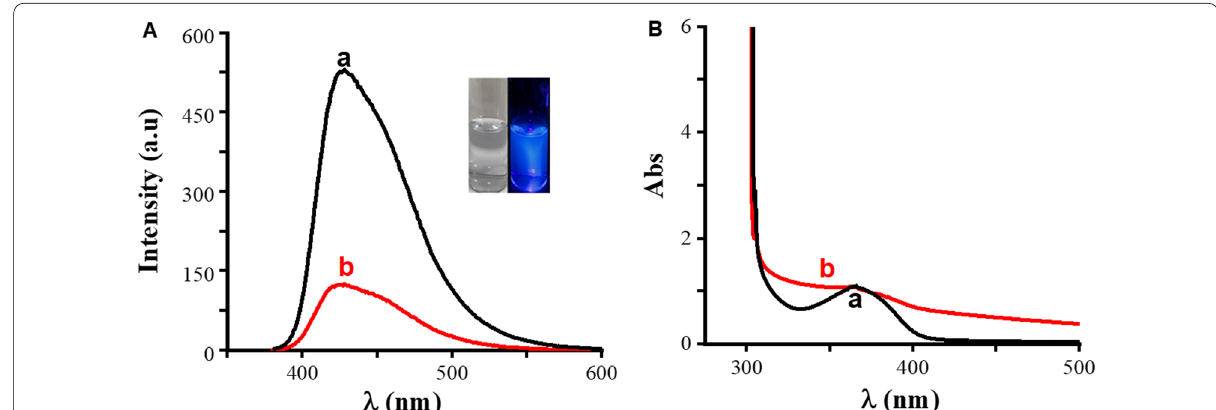
Fig. 2 A Fluorescence emission spectra of (a) CuNCs@ZIF-8, (b) CuNCs alone. The inset image shows the digital photographs of (right) pure CuNCs@ZIF-8, (left) CuNCs@ZIF-8 under ultraviolet light of 365 nm. B Absorption spectra of (a) CuNCs@ZIF-8, (b) CuNCs both of them the absorption spectrum at 364